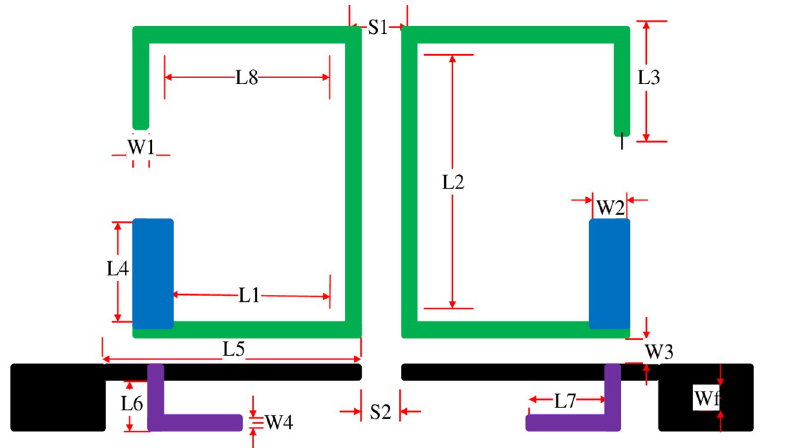
Fig 2. Proposed topology of the tri-band